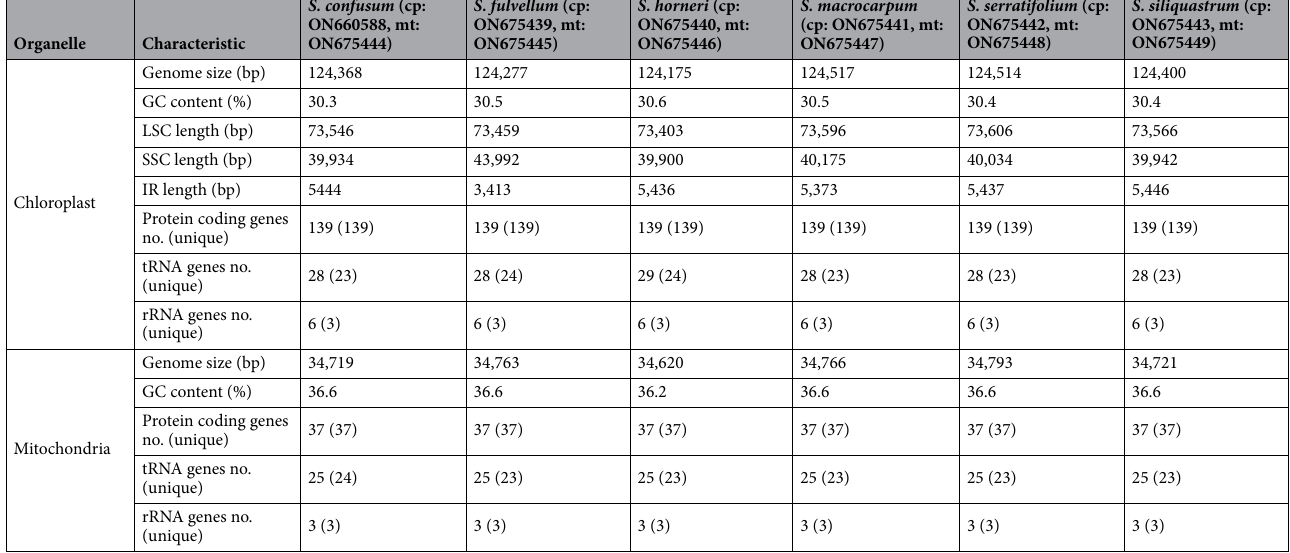
Table 1. General features of complete organellar genomes of six Sargassum species.